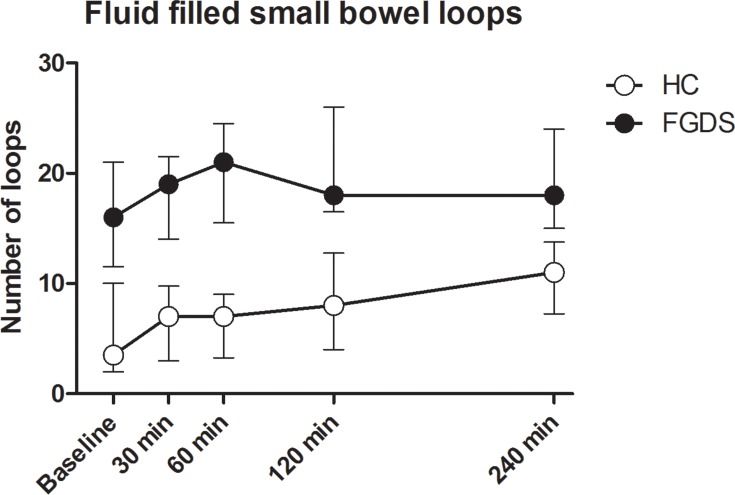
Fluid- filled small bowel loops.The number of fluid-filled small bowel loops obtained by ultrasound.There were significant differences between FGDS and HC for all measured points (p<0.001). Error bars are shown as median with IQR (25 and 75 percentiles).